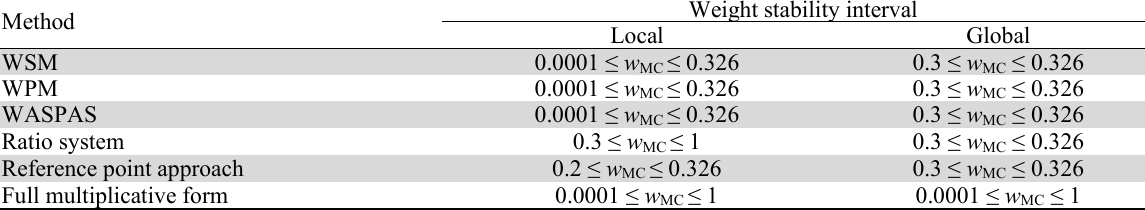
Fig. 3. Results of high dimensional weight sensitivity analysis for Example 1 High dimensional weight stability intervals for Example